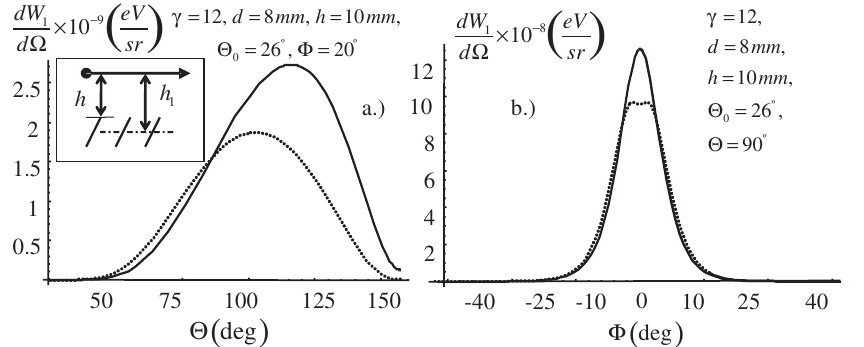
FIG. 5. Angular distribution of the SPR intensity according to the surface current model (a dotted curve) and the RDR model (solid